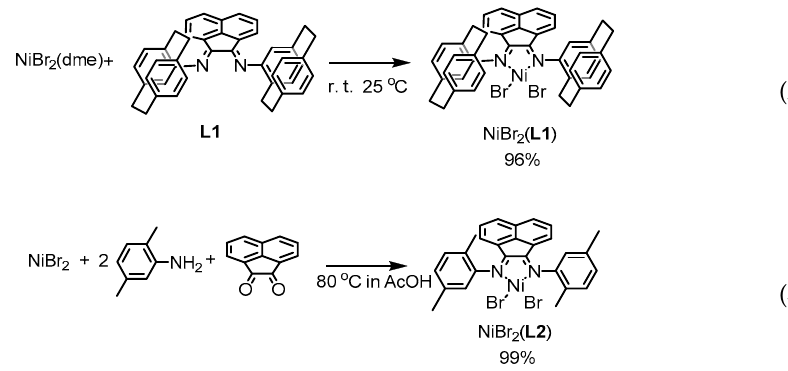
Figure 3. Crystallographic structure of NiBr 2 ( L1 )·(C 2 H 4 Cl 2 ). Selected bond distances (Å) and angles (°): Ni1–Br1 2.3375(15), Ni1–Br2 2.3392(16), Ni1–N1 2.028(5), Ni1–N2 2.035(5), Br1–Ni1–Br2